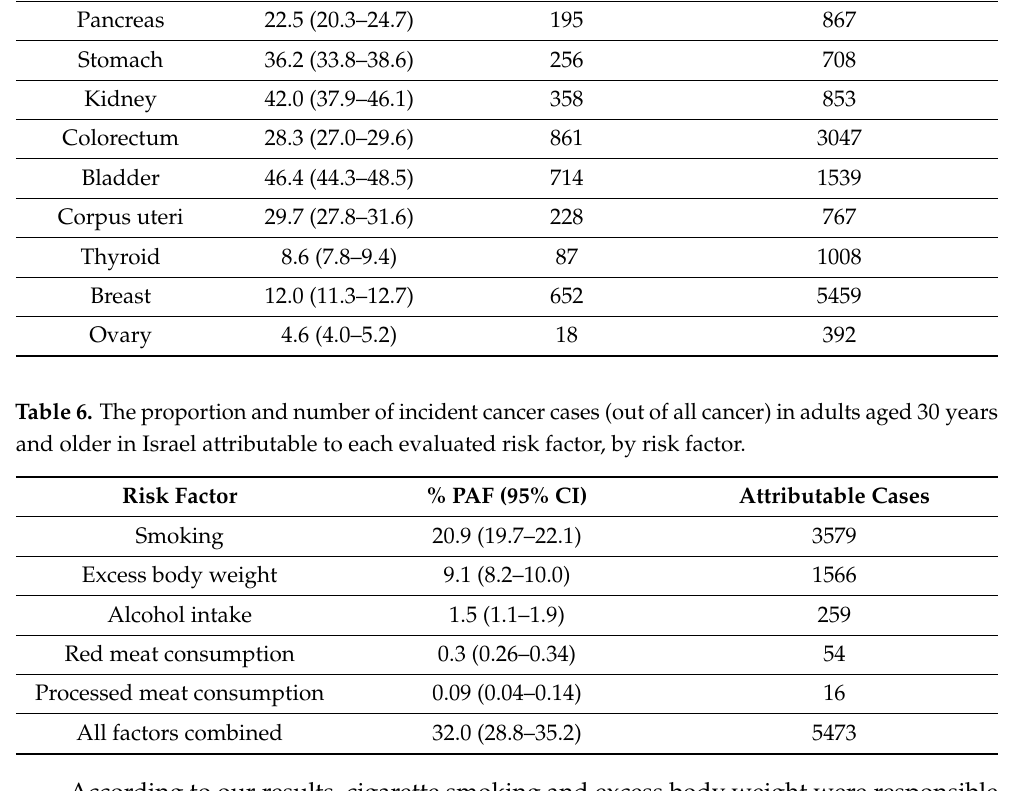
Total No. of Cases in 2015